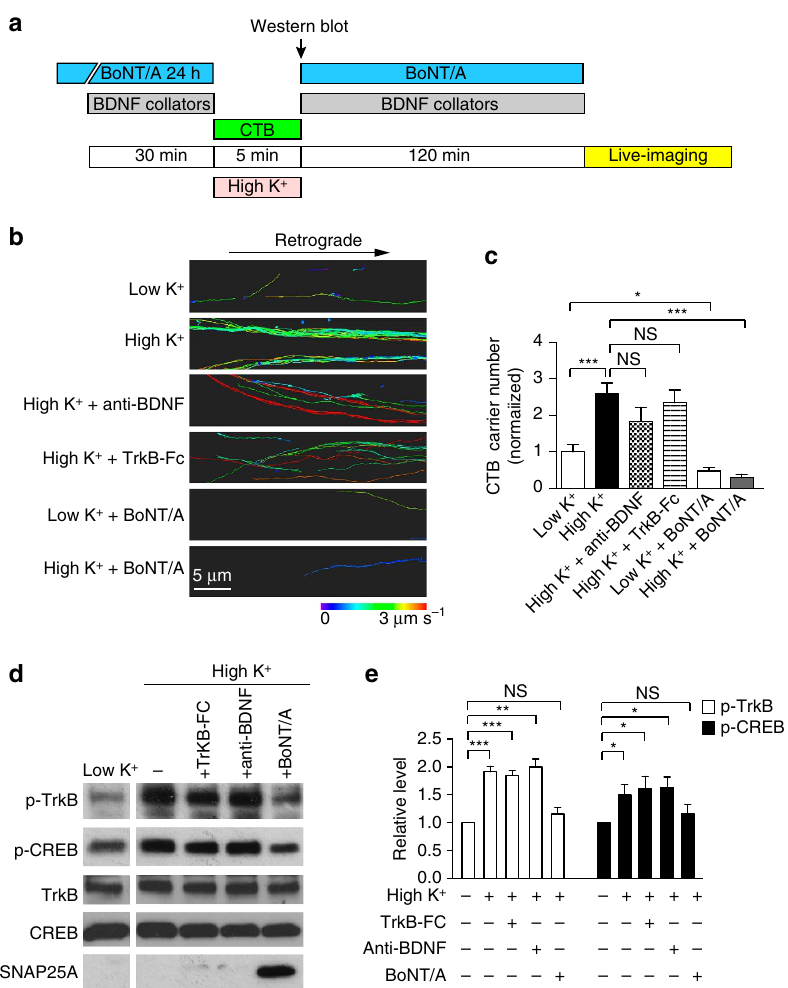
Figure 9 | Activity-dependent CTB retrograde flux is dependent on synaptic activity but not endogenous BDNF secretion. ( a ) Hippocampal neurons cultured in microfluidic chambers were pretreated with 100pM BoNT/A for 24h or 20 m gml (cid:2) 1 BDNF collators (BDNF blocking antibody; TrkB-Fc) for 30min before 5min CTB pulse in low or high K þ buffers as indicated. After wash-off, the chambers were chased in the original culture medium containing BoNT/A or BDNF collators for 2h, then live-imaged with confocal microscopy. For western blotting, neurons were collected without the 2h chase. ( b ) Imaris tracing of CTB tracks in representative live-imaging movies as treated in a , colour-coded average speed 0–3 m ms (cid:2) 1 . Scale bar, 5 m m. ( c ) Number of retrograde CTB carriers with indicated treatments (mean ± s.e.m., n ¼ 14, 31, 26, 13, 17 and 17 for low K þ , high K þ , high K þ þ anti-BDNF, high K þ þ TrkB-Fc, low K þ þ BoNT/A and high K þ þ BoNT/A, respectively, data are from three independent cultures, student’s t- test, * P o 0.05; *** P o 0.001; NS, not significant). ( d ) Western blot of treated hippocampal neurons showing that the high K þ -induced increases in p-TrkB and p-CREB were not affected by BDNF collators but were abolished by BoNT/A treatment; total TrkB and CREB protein levels were used as controls. ( e ) Quantification of ( d ). (mean ± s.e.m., n ¼ 3, data from three independent cultures, * P o 0.05; ** P o 0.01; *** P o 0.001; NS, not significant; Student’s t